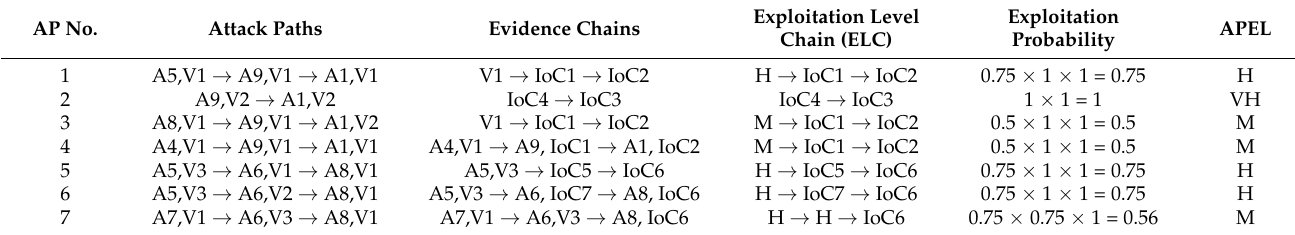
Table 8. Prioritised attack